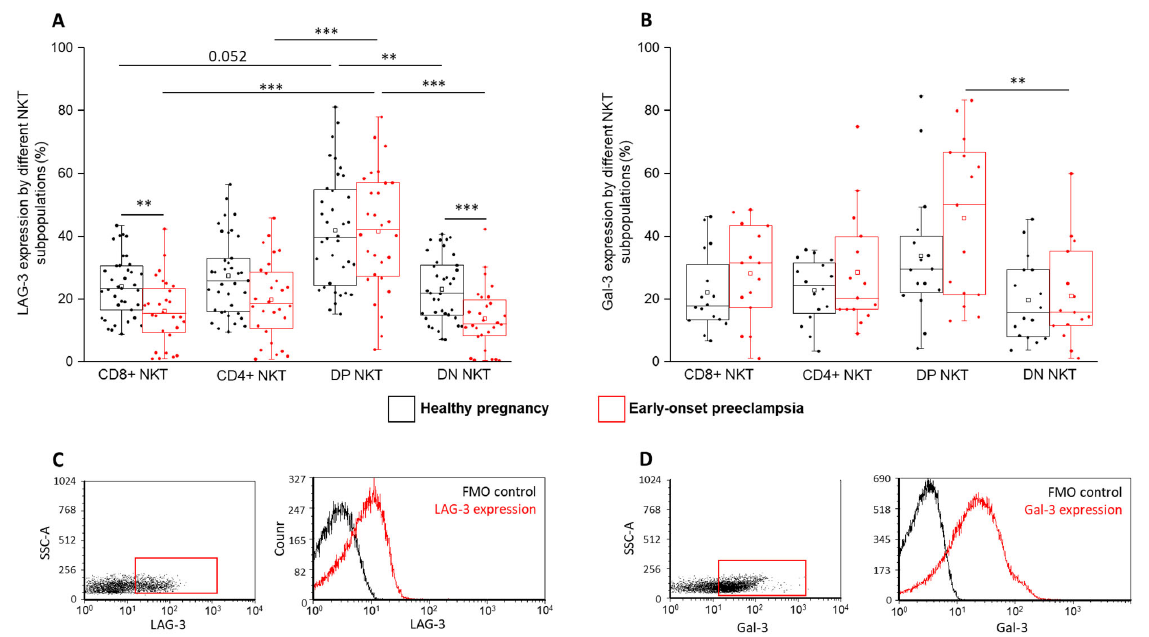
Figure 4. LAG ‐ 3 and Gal ‐ 3 expression by different NKT cell subpopulations in EOP and healthy pregnancy. LAG ‐ 3 receptor ( A ) and Gal ‐ 3 ligand expression ( B ) by the CD8 and CD4 surface molecule positive and negative NKT cell subpopulations in EOP patients and healthy pregnant women. The solid bars represent medians of 37, 28, 16 and 15 determinations, respectively. The boxes indicate the interquartile ranges, and the whiskers show the most extreme observations. The middle square within the box represents the mean value. Significant differences with p ‐ values <0.01 *** and <0.03 ** are indicated. Representative FACS plots show the expression of LAG ‐ 3 ( C ) and Gal ‐ 3 molecule ( D ) by cells in the lymphocyte gate. FMO control was used to determine LAG ‐ 3 and Gal ‐ 3 positivity.